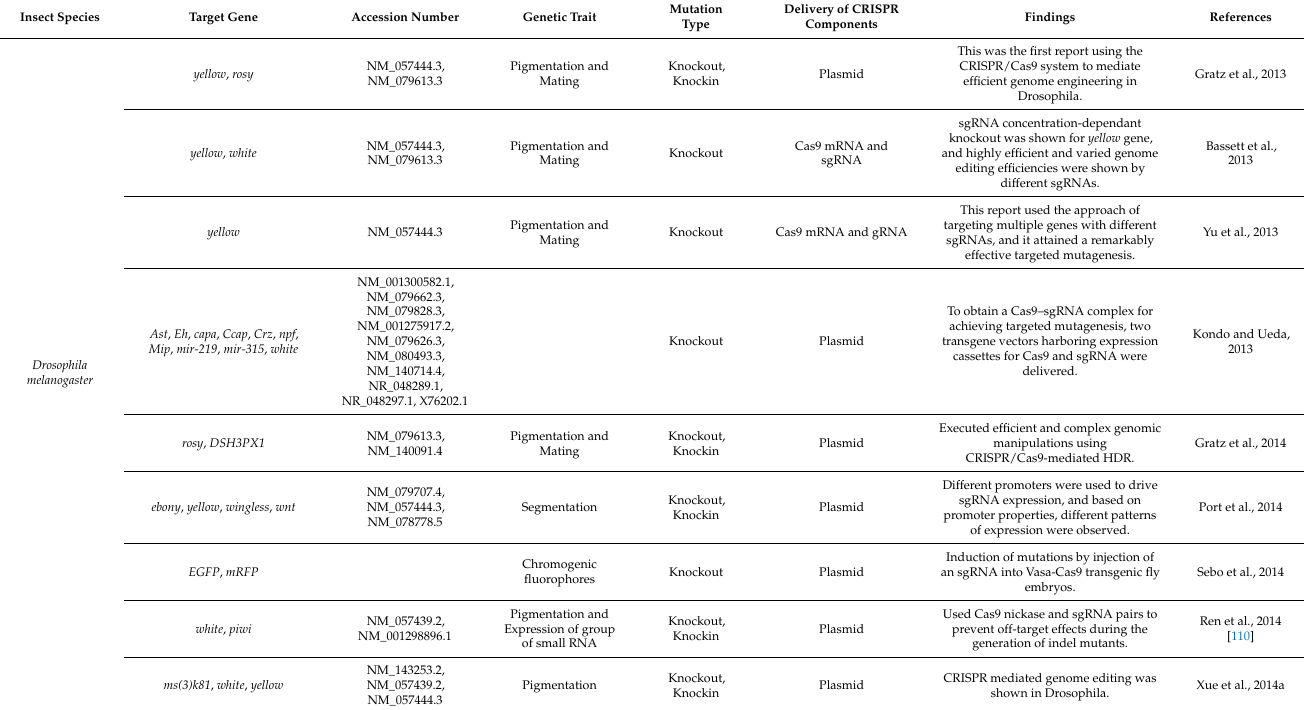
Table 1. CRISPR/Cas9-based genome editing in various